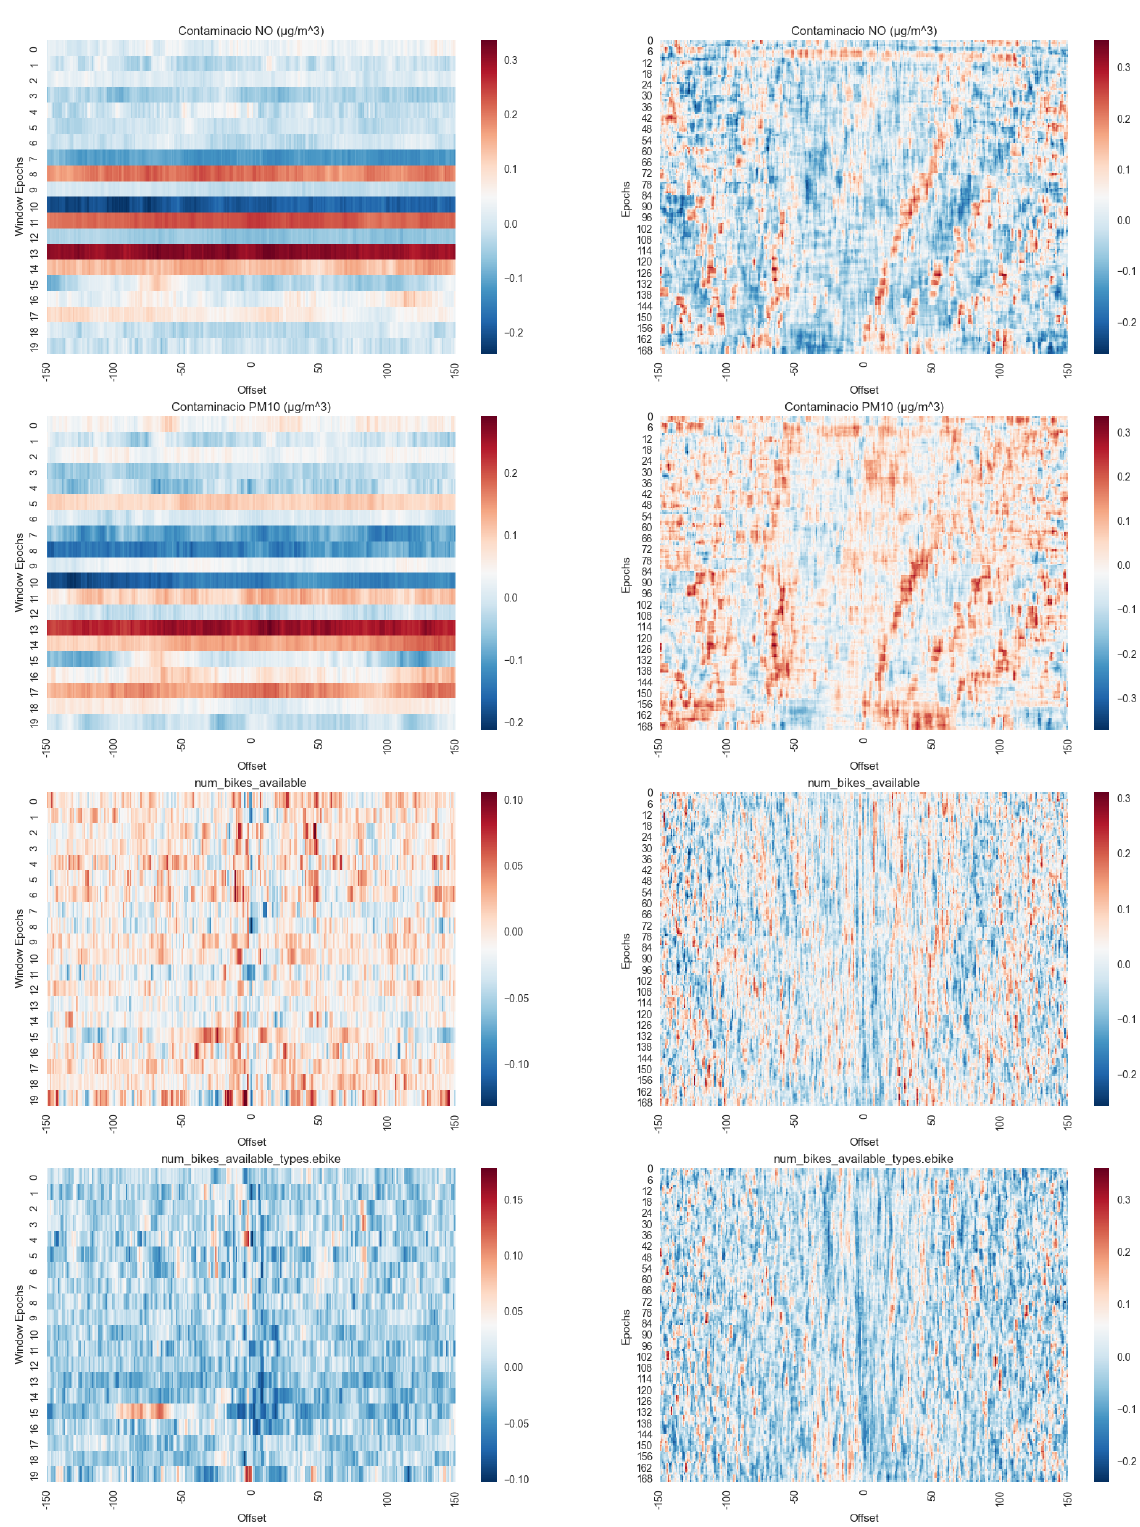
Figure A1. Windowed Time Lagged Cross Correlation ( Right ) and Rolling Windowed Time Lagged Cross Correlation ( Left ) for a subset of variables compared to traffic